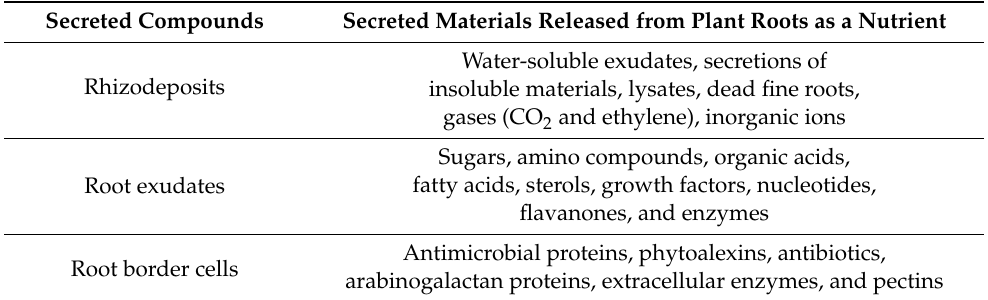
Figure 1. Types of root exudation processes that provide nutrients for plant growth-promoting rhizobacteria (PGPR) root colonization and growth based on classes of compounds, secretions, and their functions in the rhizosphere [15,55–57,63,68]. Table 1. Organic bioactive compounds secreted as rhizodeposits, root exudates, and root border cells in the rhizosphere that repel plant pathogens and attract beneficial rhizobacteria